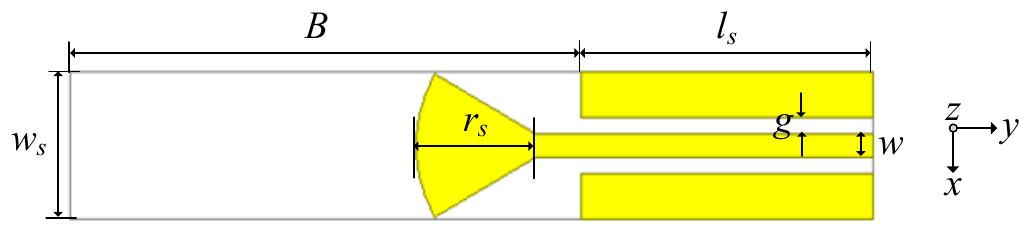
Figure 1. The configuration of the transformer. ( a ) 3D view; ( b ) side view; and ( c ) H plane bend.